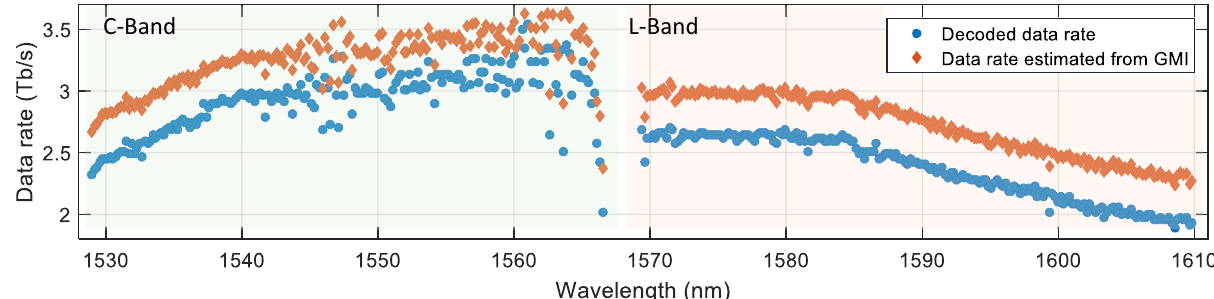
Fig. 5 Wavelength dependence of the signal quality after transmission. The data rate of each of the 382 spatial super-channels was estimated by an implemented coding scheme and from generalized mutual information (GMI). The C-band performed overall better compared to the L-band due to a combination of reduced mode-dependent loss and phase-noise from the comb source.